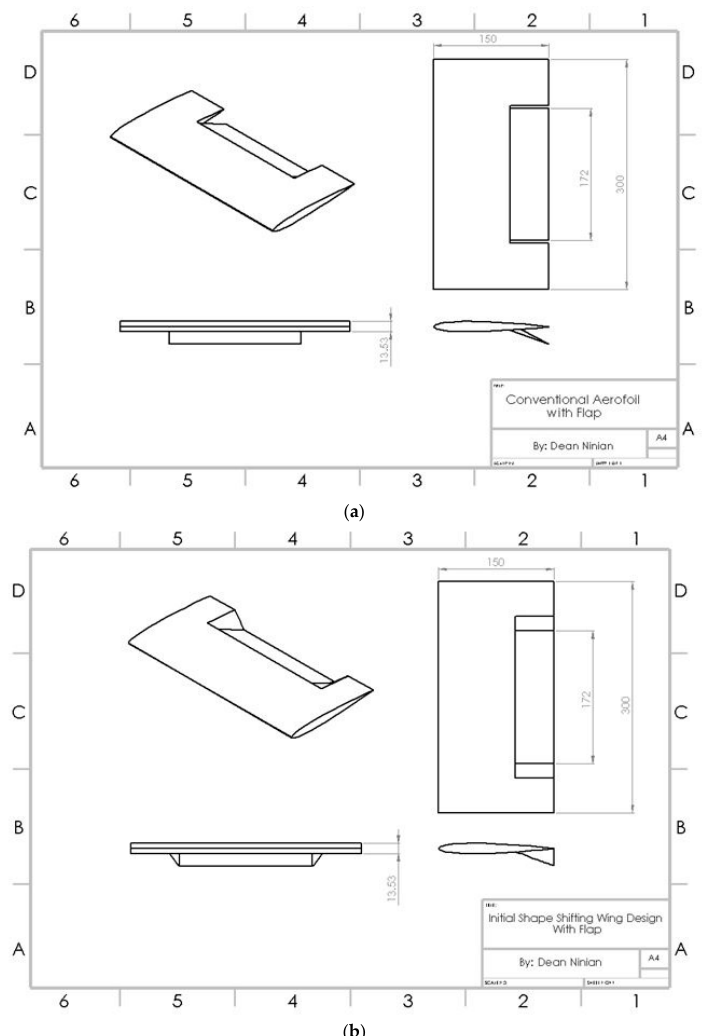
Figure A1. ( a ) Conventional aerofoil with flap, units in mm; ( b ) Initial shape shifting wing design with flap, units in mm.